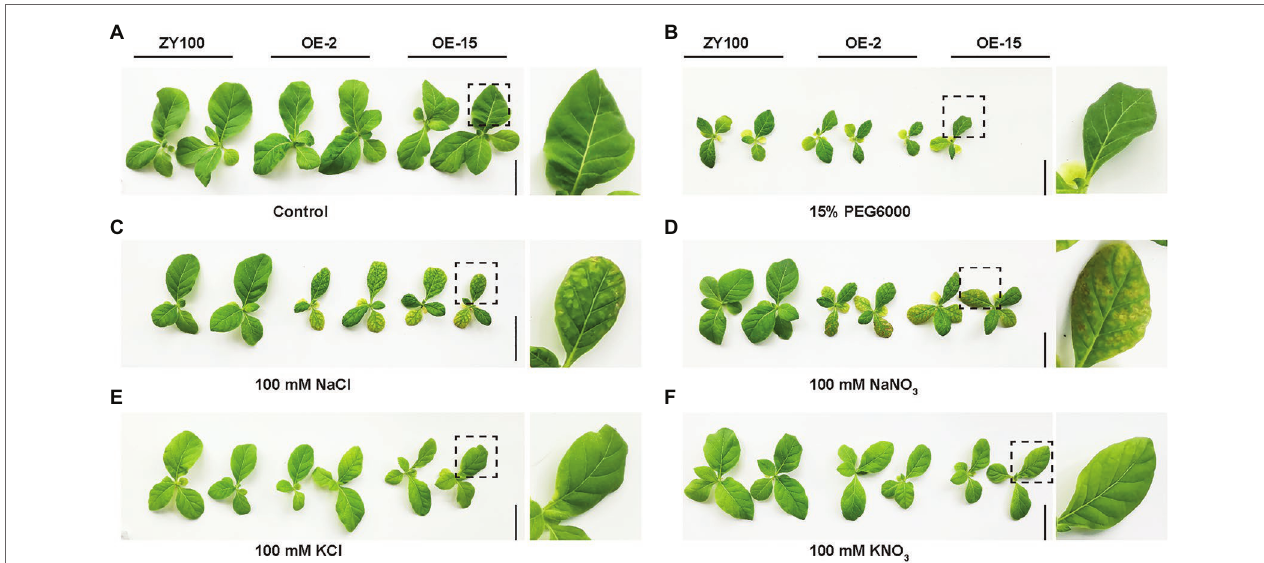
FIGURE 6 | Ion and osmotic stress evaluation on WT and NtCBL5A -overexpressing lines (OE-2 and OE-15) at 9 DAT. (A) The phenotype of WT and NtCBL5A -OE lines under control condition (1/2 Hoagland’s nutrient solution). (B) The phenotype of WT and NtCBL5A -OE lines under osmotic stress (1/2 Hoagland’s nutrient solution added 15% PEG6000). (C–F) The phenotype of WT and NtCBL5A -OE lines under ion stresses (1/2 Hoagland’s nutrient solutions added 100 mM NaCl, 100 mM NaNO